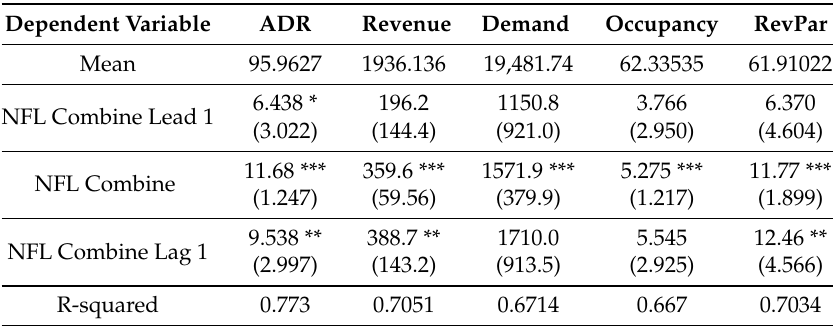
Table 12. The impact of the NFL Combine on the hotel